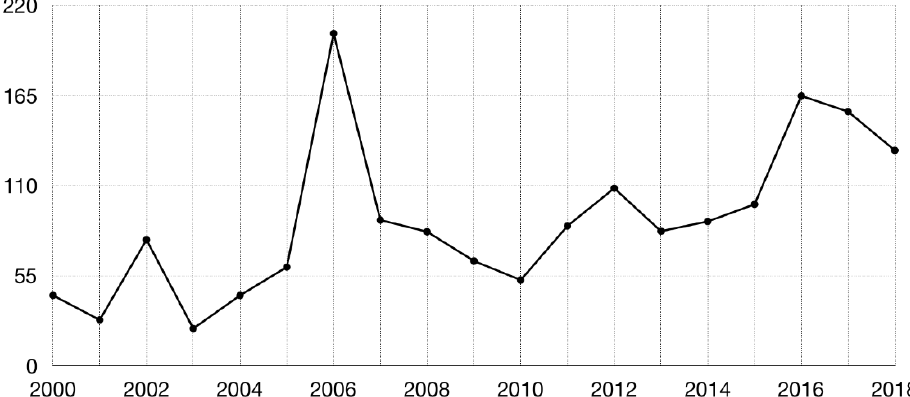
Figure 3. Ratio of the numbers of papers containing either the expression “molecular docking” or “ligand docking” to the number of papers containing either of the two expressions AND the word consensus.